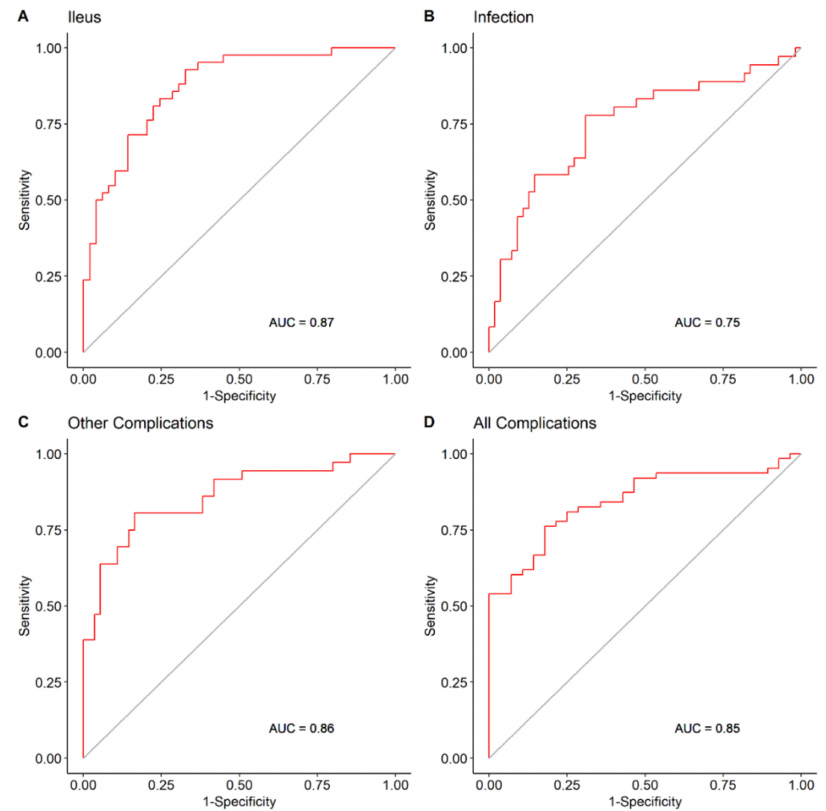
Figure 4. SMI change based multivariable models’ accuracy in predicting